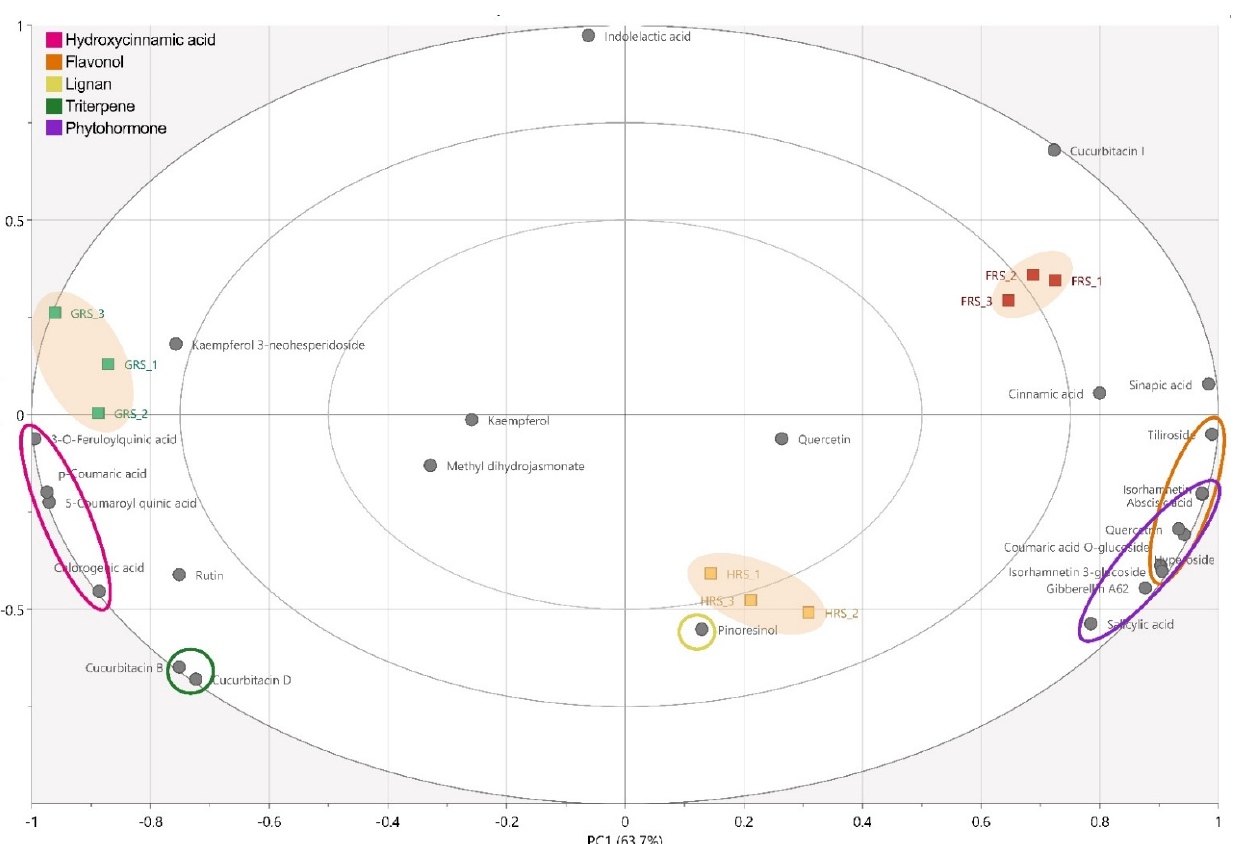
Figure 1. PCA biplot obtained from LC–MS data of Coccinia grandis fruits at different stages of ripening.